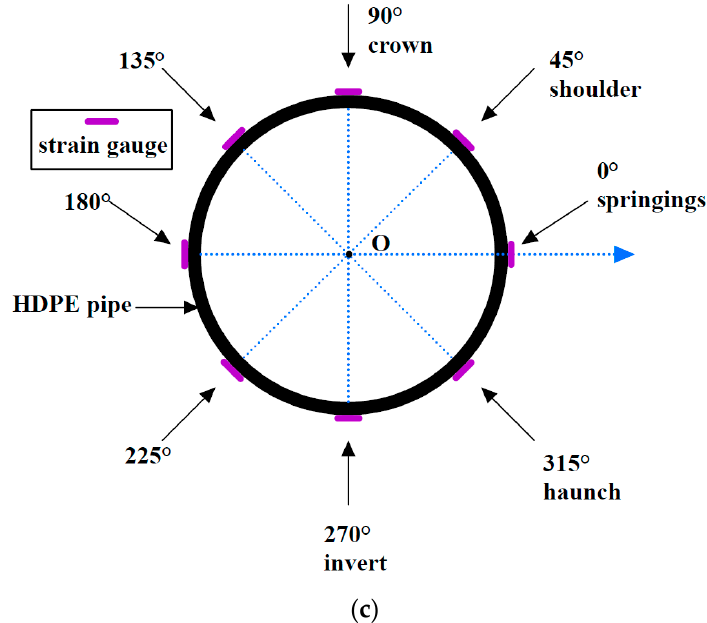
Figure 1. Test system: ( a ) schematic drawing; ( b ) sections for strain gauges arrangement; ( c ) strain gauge distribution on each section.